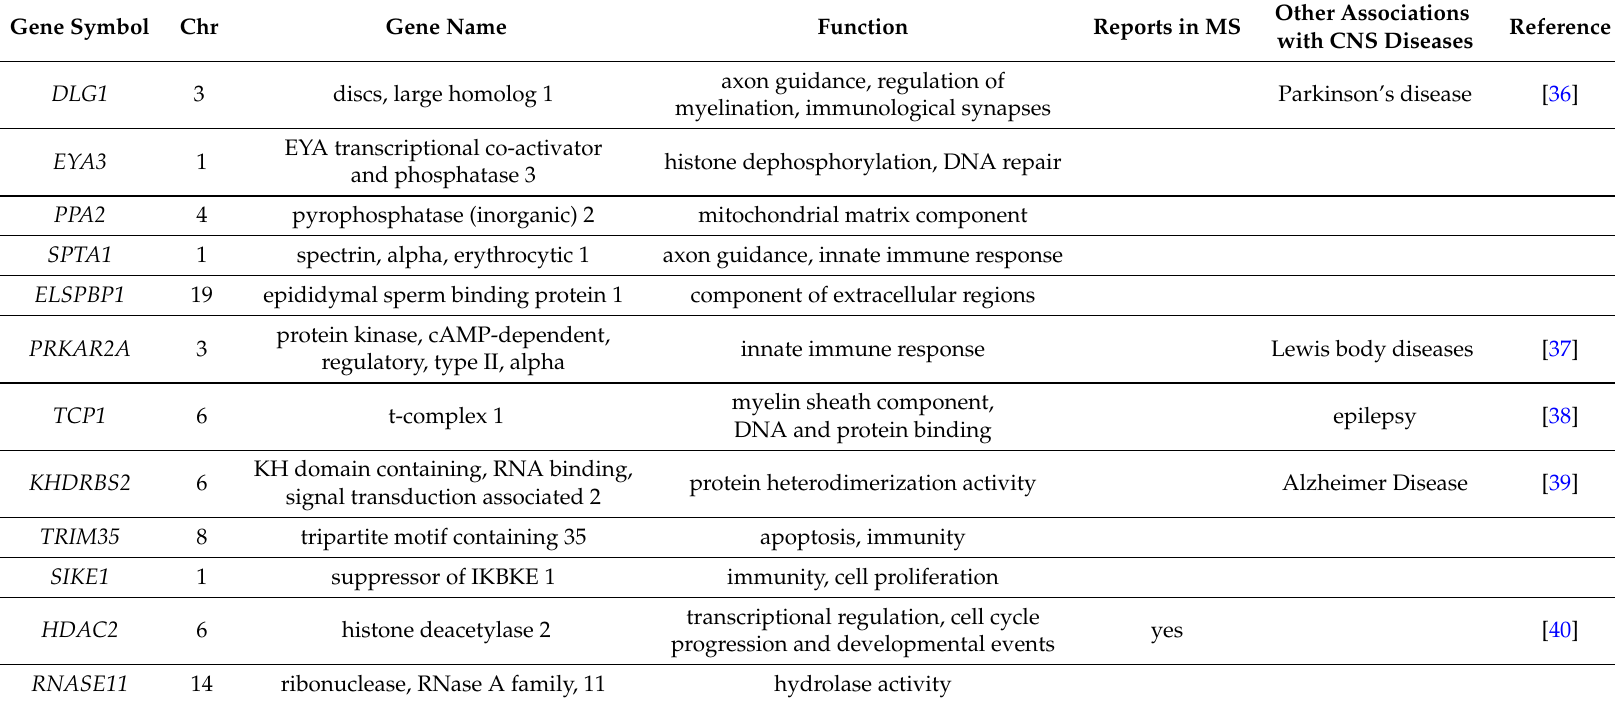
Table 4. Genes DC at the level of 0.05 in the MS vs. HC comparison in at least 2